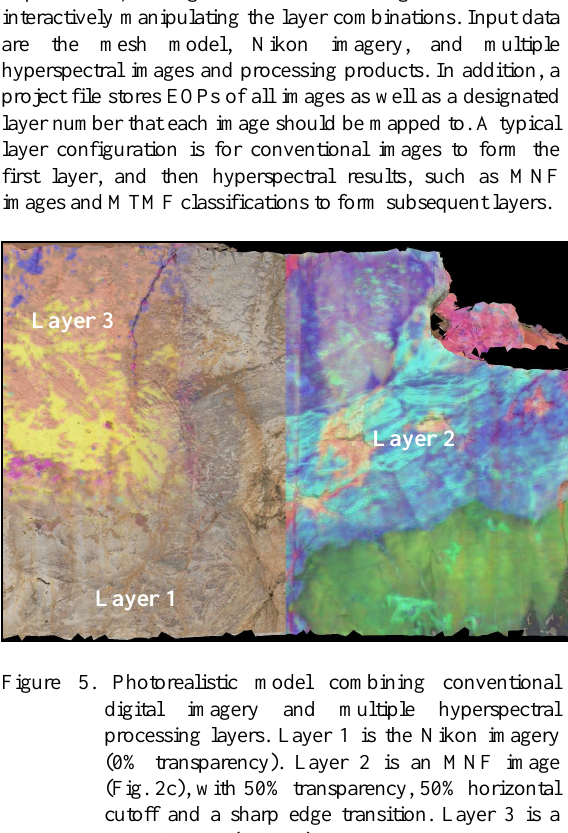
Figure 4. Lidar geometry coloured using classification image in Fig. 2. a) point cloud; b) mesh. Height of area c. 15 m.